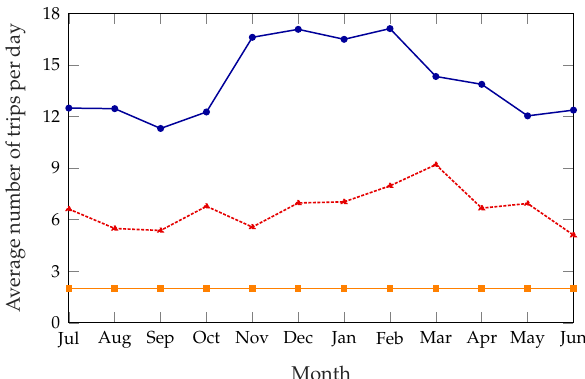
Figure 11. Average number of rebalancing trips per day with perfect and imperfect demand information, plotted over 12 months.